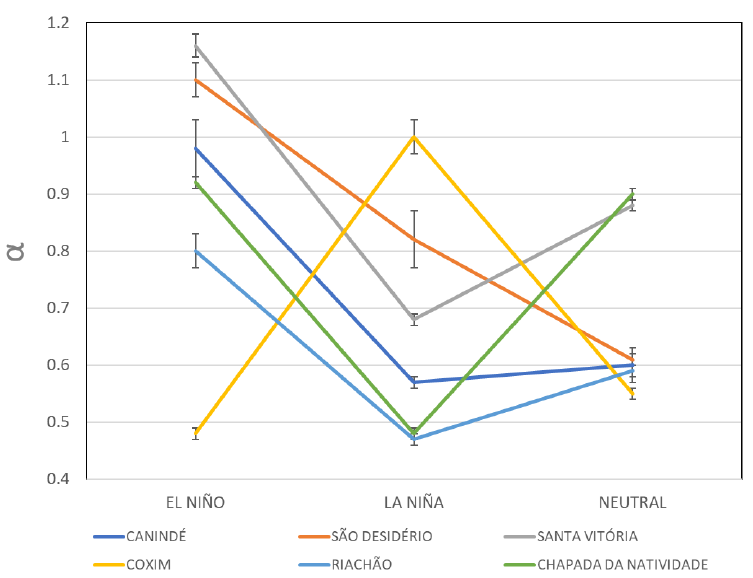
Figure 5. Cities that presented a huge range variation in the α for solar radiation for a time scale window greater than ten days. Canindé, São Desidério, and Santa Vitória were impacted by the El Niño season, moving from a persistent state to a sub-diffusive one. Coxim moved from an anti-persistent state to a sub-diffusive during the La Niña season. Chapada da Natividade were impacted by El Niña, and reached an anti-persistent α value. The error bar represents one standard error of the DFA coefficient.